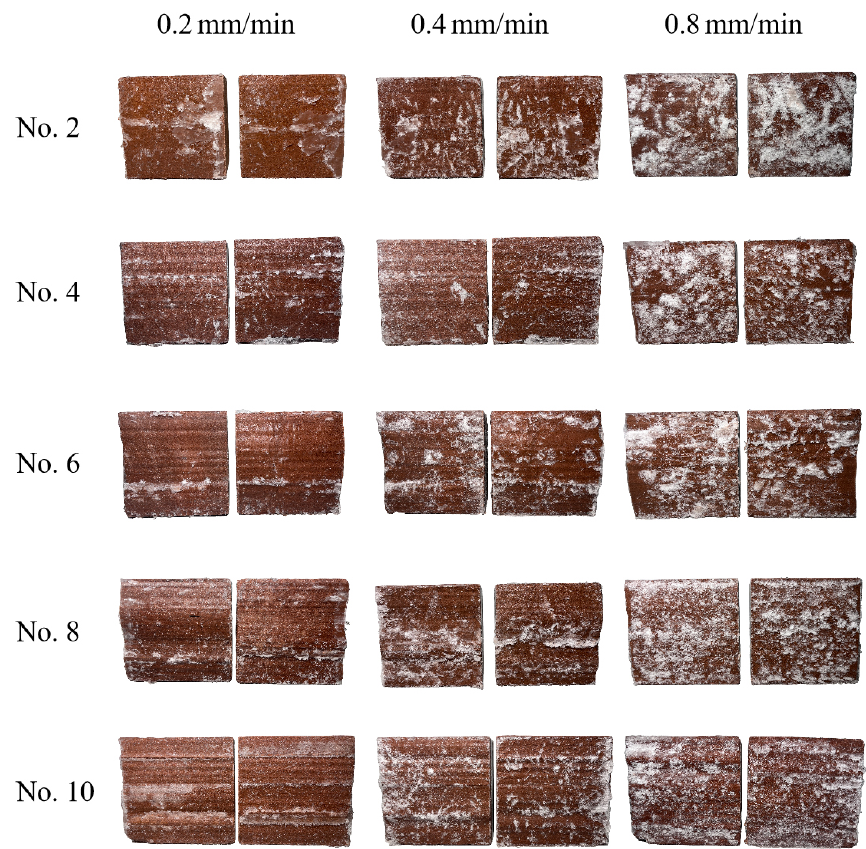
Figure 12. The shear rupture characteristics of joint ice under different shear rates. Experimental conditions: T =− 5 ◦ C, d = 2mm and σ n = 0.5MPa. The ice crystal that cannot adapt to shear slip at high shear rates induces brittle failure. The joint ice of brittle failure shows more micro-fractures, which make it more reflective. This causes a white appearance of the rupture ice on the joint surface. The ductile failure of ice displays a transparent appearance without a white color, which is hard to observe. Therefore, a larger area of white appearance implies a much more serious brittle failure of joint